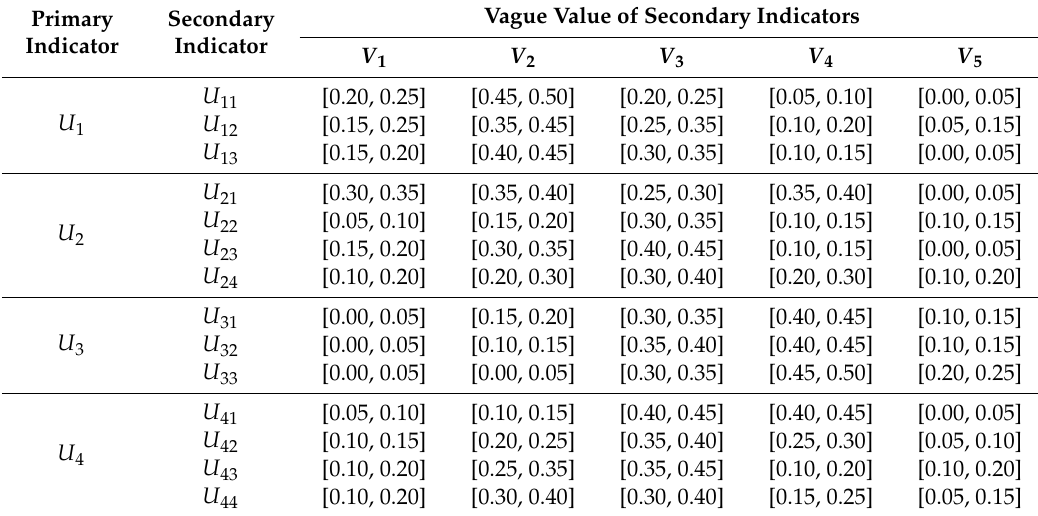
Table 4. Vague value of secondary indicators (Project 1).